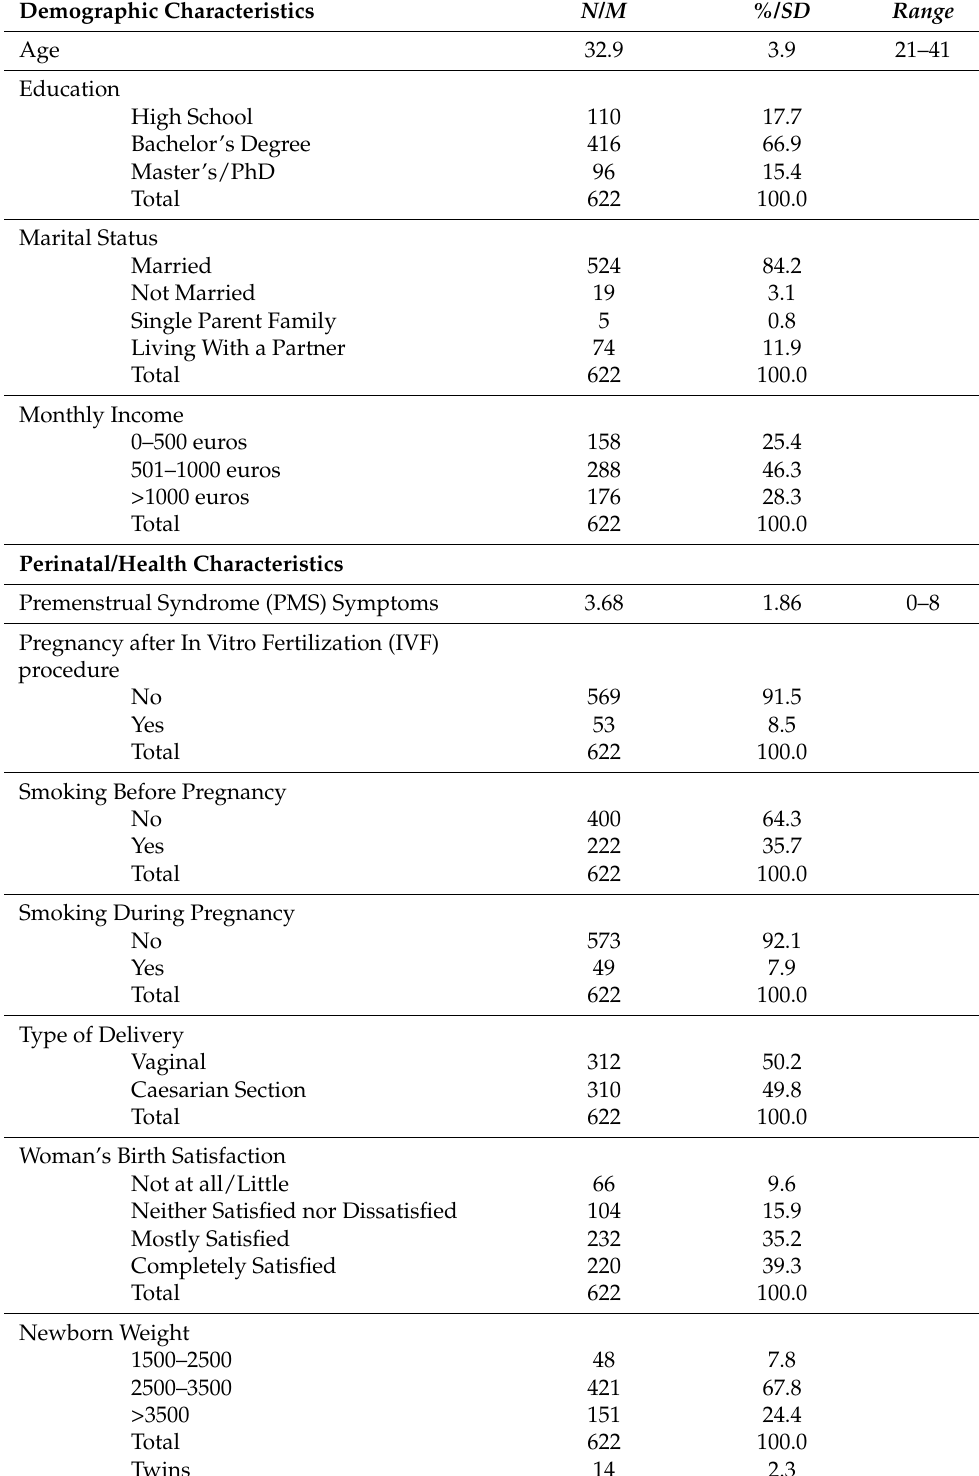
Table 1. Demographic, perinatal/health, and breastfeeding